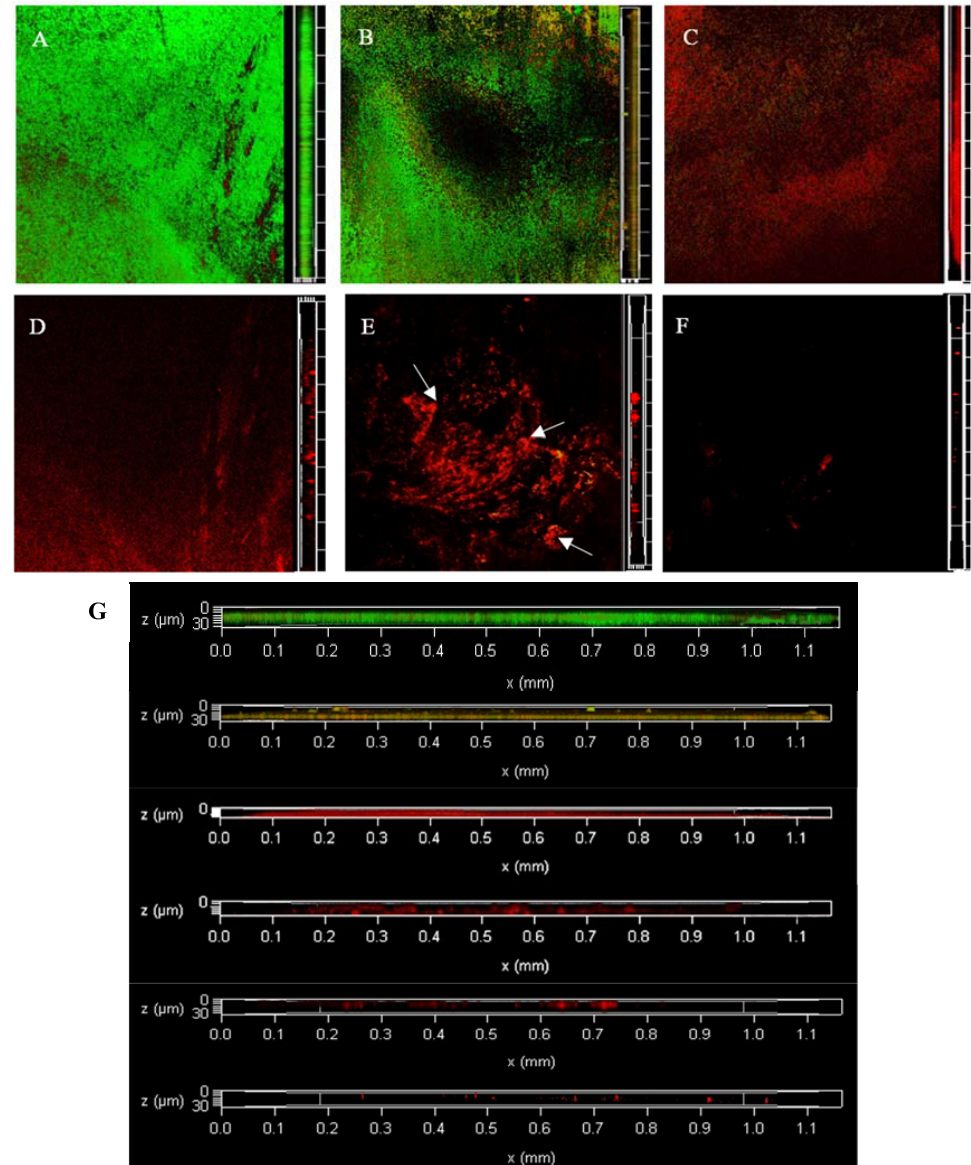
Figure 4. The changes of viable and dead colonies in LM biofilm after NEHW treatment observed by CLSM; each sample randomly selects three visual fields. Images include front and side views of the biofilm under CLSM. Scale bar—100 µ m. ( A – F ) represent the dead or alive status of the remaining bacteria after 0, 2, 4, 6, 8 and 10 min of treatment, respectively. ( G ) is an enlarged version of all the images on the right and is also a right-hand view of the biofilm, from top to bottom, for NEHW treatments 0, 2, 4, 6, 8 and 10 min respectively. NEHW was the abbreviation of non-electrolytic hypochlorite water. Green—live cells, red—dead cells. The arrows point to areas of denser biofilm.